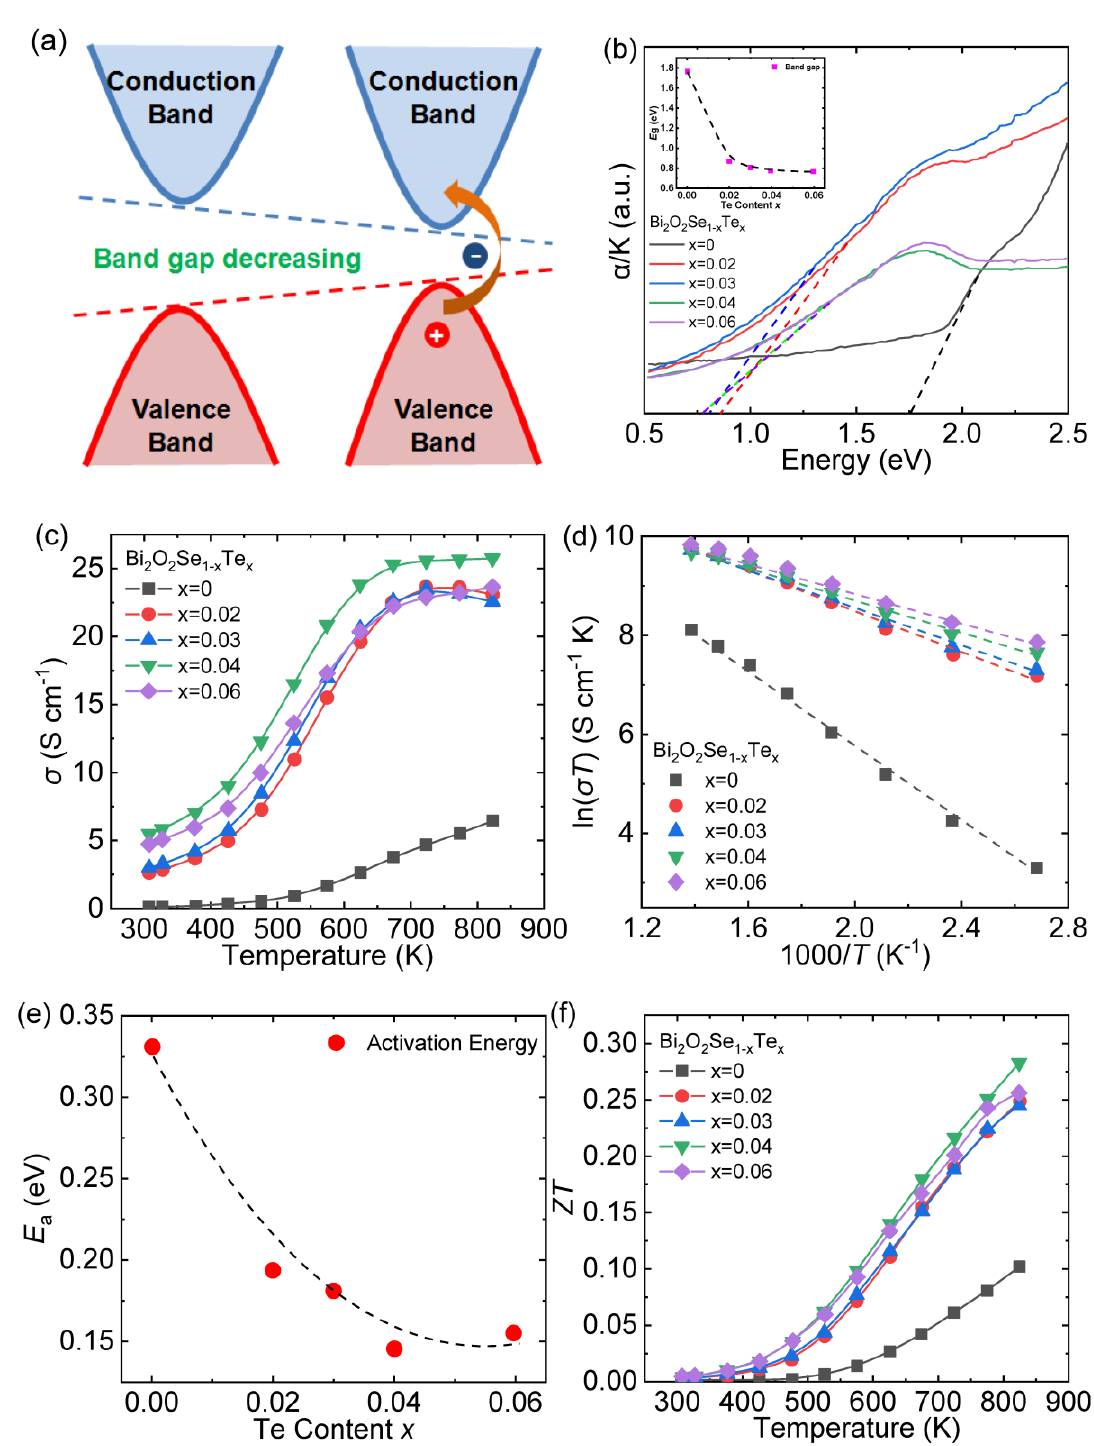
Figure 8. ( a ) The schematic diagram of narrowing the band gap; ( b ) the optical absorption spectra of Bi 2 O 2 Se 1-x Te x ( x = 0–0.06) and the band gap varying with Te content shown in the inset; ( c ) electrical conductivity, ( d ) the fitting plot of the electrical conductivity by the small polaron model, ( e ) the activation energy ( E a ) and ( f ) ZT of Bi 2 O 2 Se 1-x Te x ( x = 0–0.06). Data shown in ( b – f ) were adopted from Reference [44]. Copyright 2017, The American Ceramic Society. Ultimately, the low carrier concentration of pristine Bi 2 O 2 Se (~10 15 cm − 3 ) was boosted to ~10 18 cm − 3 , which was increased by three orders of magnitude [44]. The greatly in- creased carrier concentration makes the σ of all the Te-doped samples significantly larger than pristine Bi 2 O 2 Se throughout the entire test temperature range (Figure 8c). To obtain insight into the electrical transport behavior, the small polaron hopping conduction theory mentioned in the previous work [70] was selected to analyze the elec- tric conductivity. The strong linear correlation between ln( σ T ) and 1000/ T is exhibited in Figure 8d, and the curve of calculated activation energy E a varying with the Te content is